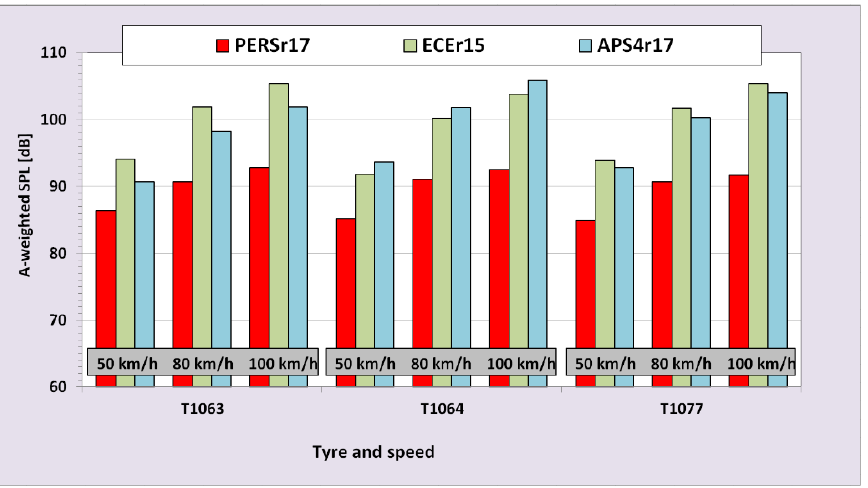
Figure 1. A ‐ weighted sound pressure level (SPL) for passenger car tire. Figure 1. A-weighted sound pressure level (SPL) for passenger car